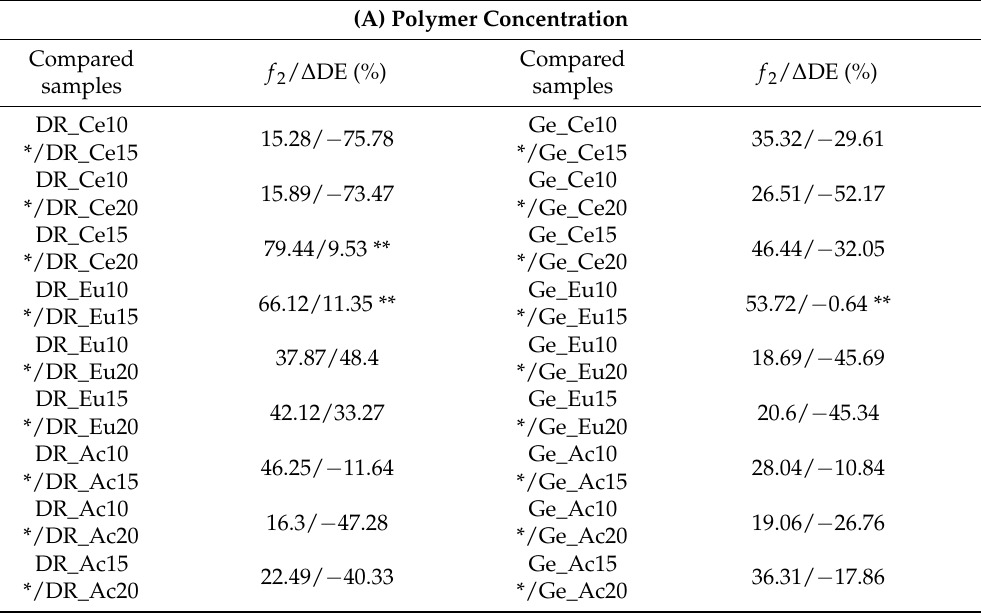
Table 4. Comparison of dissolution profiles through similarity factor f 2 and dissolution efficiency as ∆ DE (%) expressed in 3 different levels, where two parameters are constant, and one is